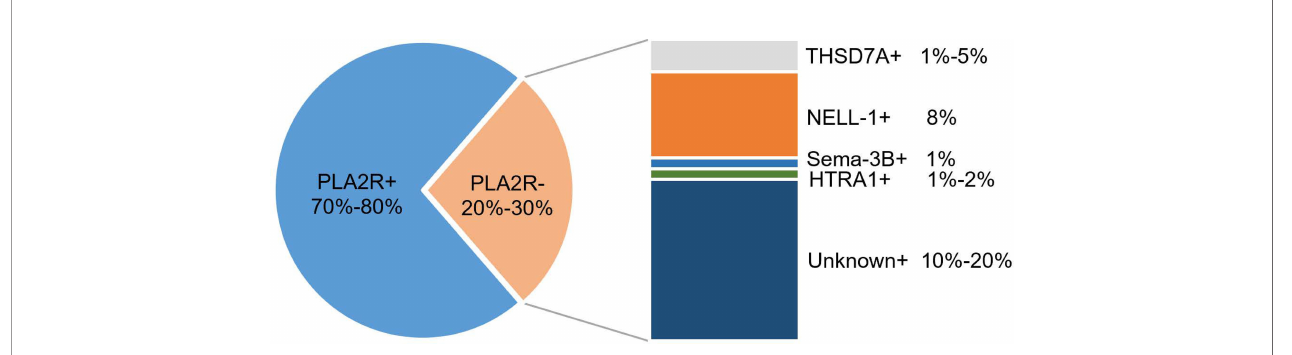
FIGURE 3 | Distribution of podocyte antigens in patients with